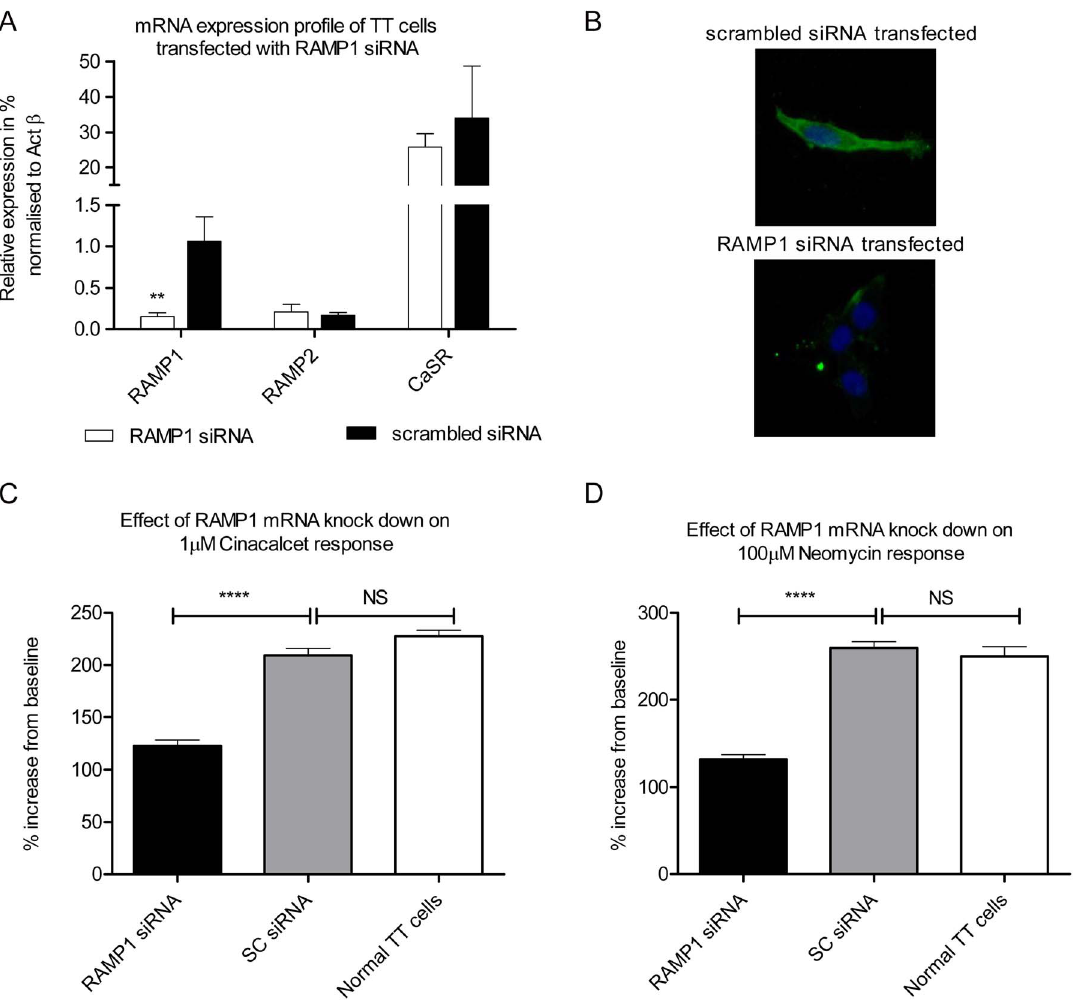
Figure 5. Effect of RAMP1 mRNA knockdown on TT cells. (A) mRNA expression levels of RAMP1, RAMP2 and CaSR in TT cells transfected with RAMP1 or scrambled siRNA, 72 hr post-transfection expressed as fold change normalised to Act b . (B) Representative images from immunofluorescent staining for RAMP1 expression in cells transfected with scrambled siRNA (top panel) and RAMP1 siRNA(bottom panel), 72 hr after transfection. (C) Intracellular calcium response of the RAMP1 siRNA cells to 1 m M Cinacalcet in presence of 1.5 mM CaCl 2 and (D) 100 m M Neomycin in presence of 2 mM CaCl 2 The responses were decreased by , 42% and , 50% respectively compared to scrambled siRNA transfected cells. The data are combined from five independent experiments with a total of 241, 231 and 154 cells analysed in (C), and 354, 354 and 118 cells analysed in (D) for knock-down, control and normal conditions respectively. **** p , 0.0001 analysed by two-tailed Mann-Whitney test.